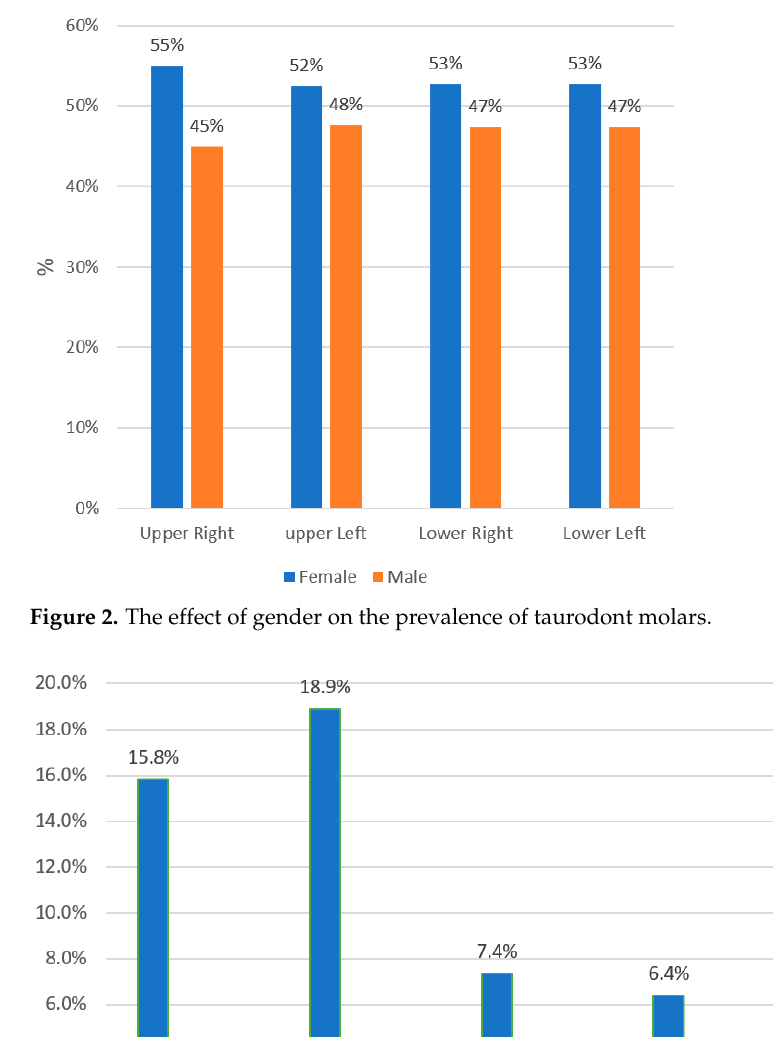
Table 3. The frequency of hypotaurodontism, mesotaurodontism, and hypertaurodontism in every molar.